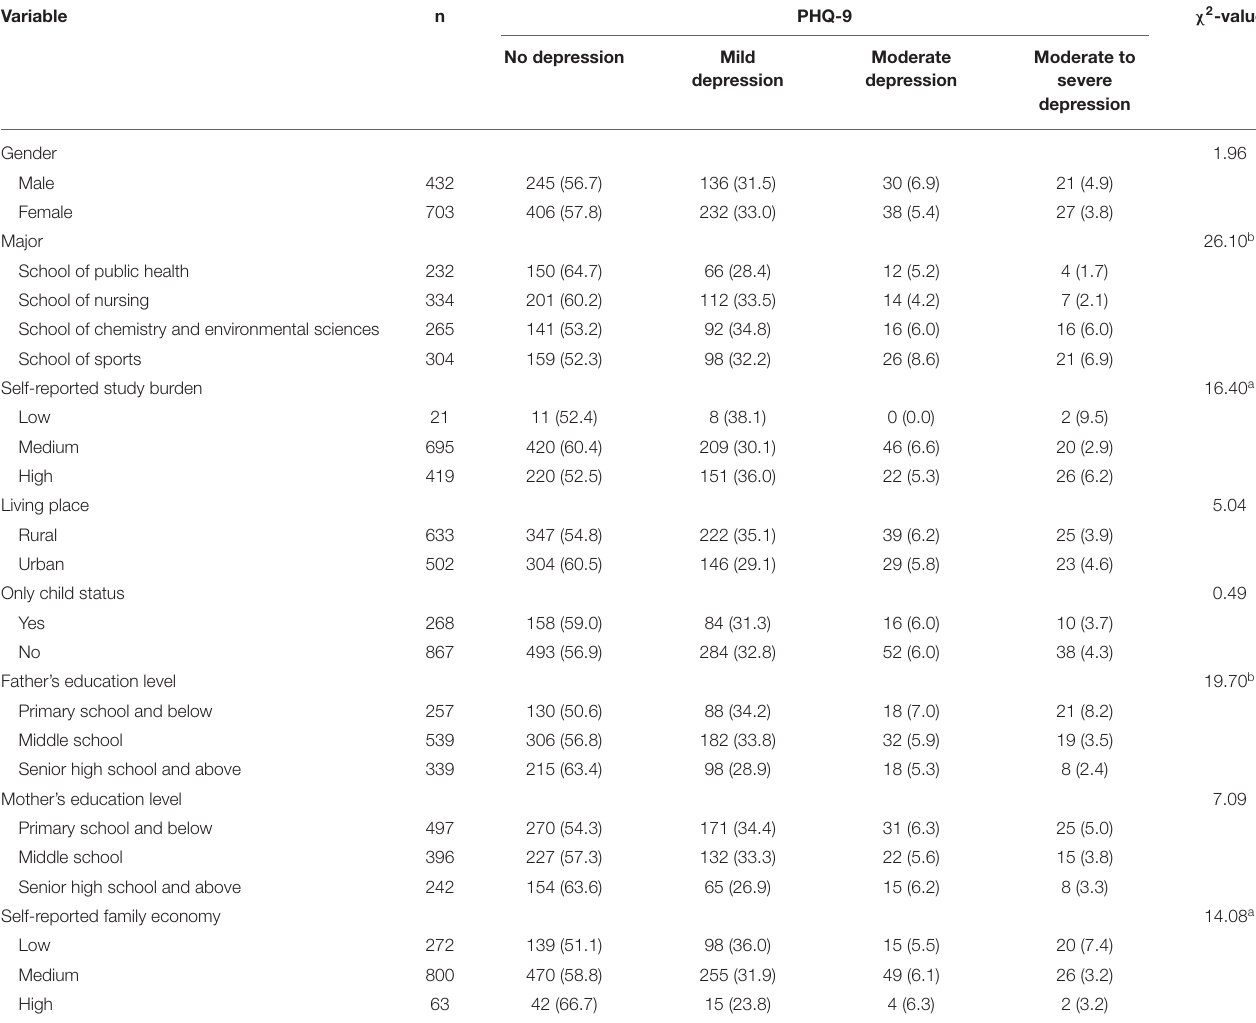
TABLE 1 | Characteristics of depressive symptoms in college students